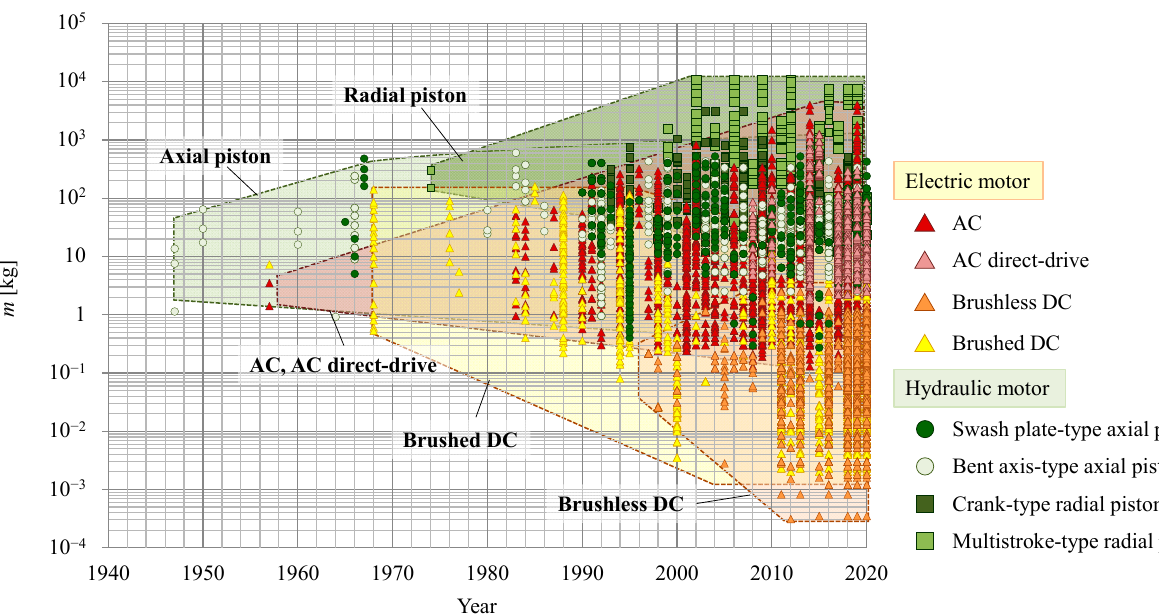
Figure 4. Transition of motor weight.